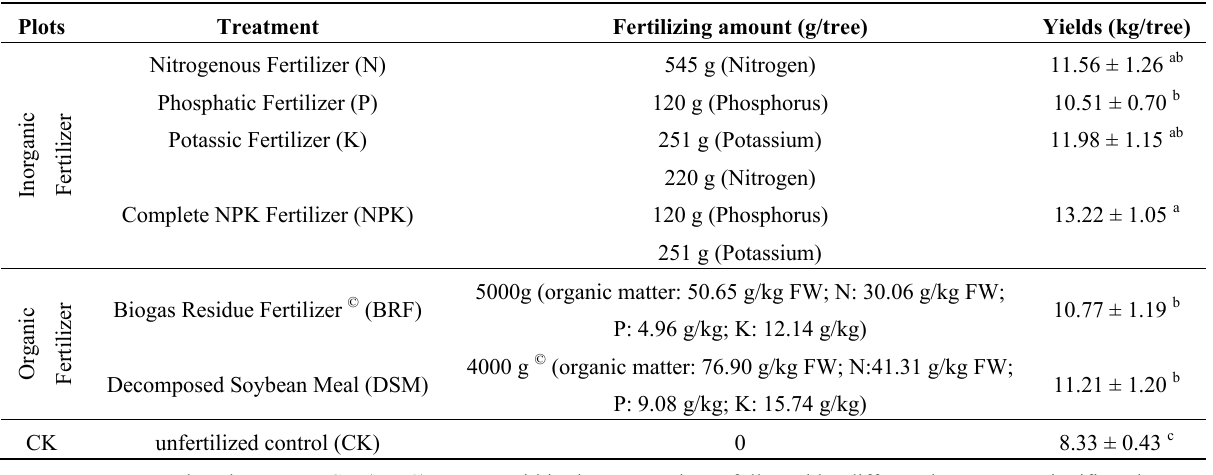
Table 1. The experimental fertilizer management and yields of jujube